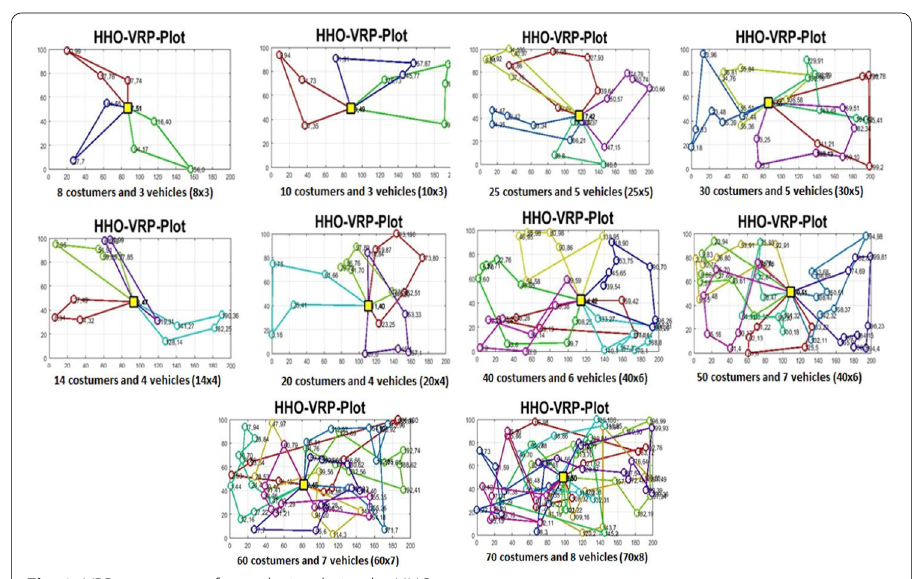
Fig. 2 VRP route maps for each simulation by